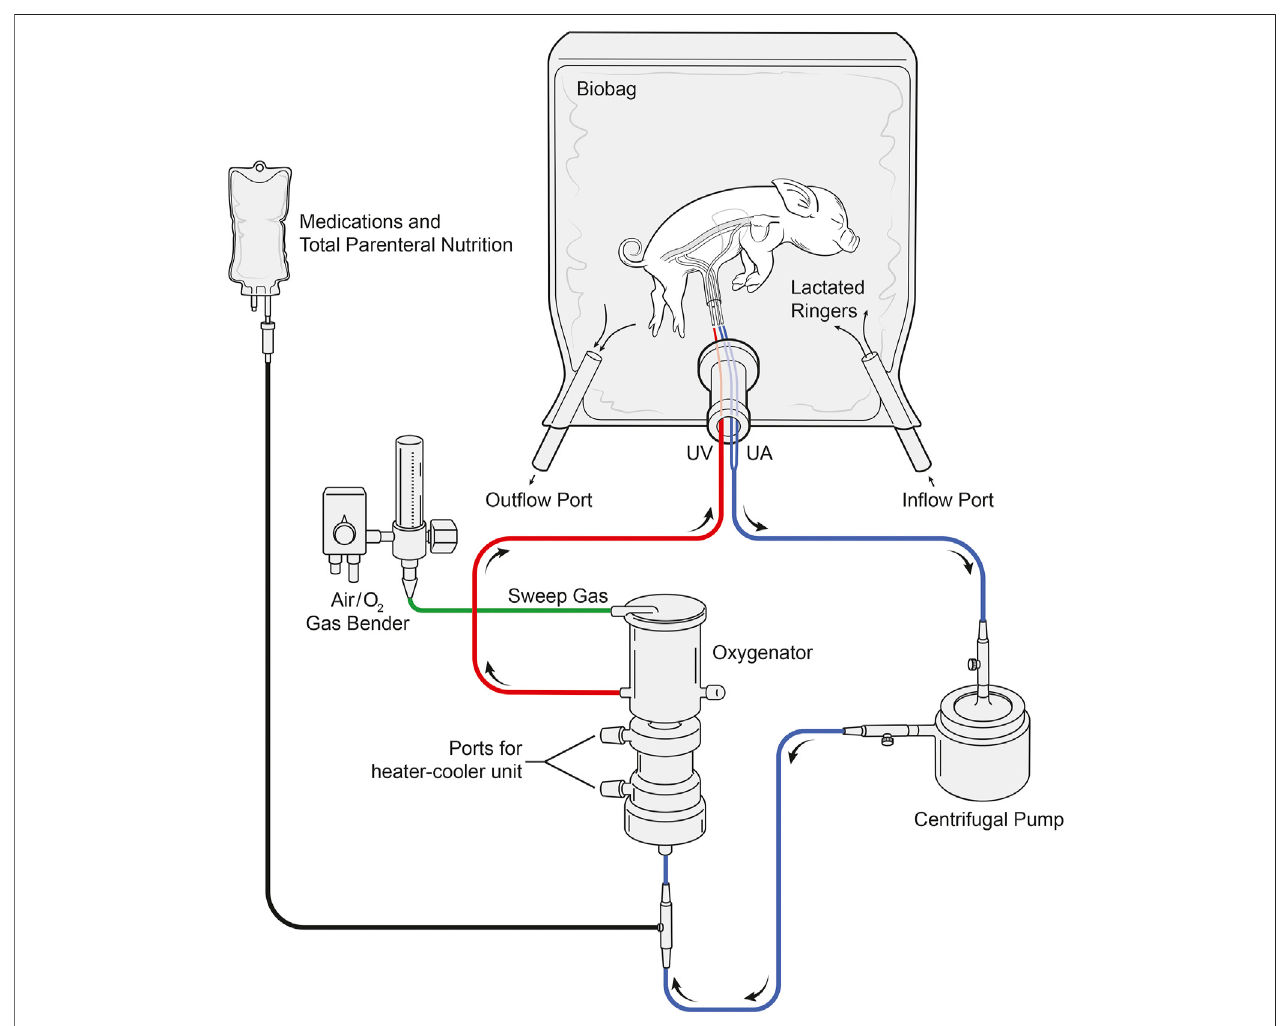
FIGURE 10 | Layout of the pumped AP circuit. Fetal pigs ( n = 13) were delivered via caesarean section, cannulated via the UA ’ s and UV, and maintained using a pumped AP circuit. Fetal pigs ( n = 12) were also maintained using the same circuit design but without a centrifugal pump. Blood passed through the UAs and the centrifugal pump before entering the in fl ow port of the oxygenator. Oxygenated blood then passes through the oxygenator out fl ow port before returning to the heart via the UV. Sweep gas supplied the oxygenator with medical air and oxygen and the Biobag was fi lled with warmed LR solution to maintain fetal normothermia.